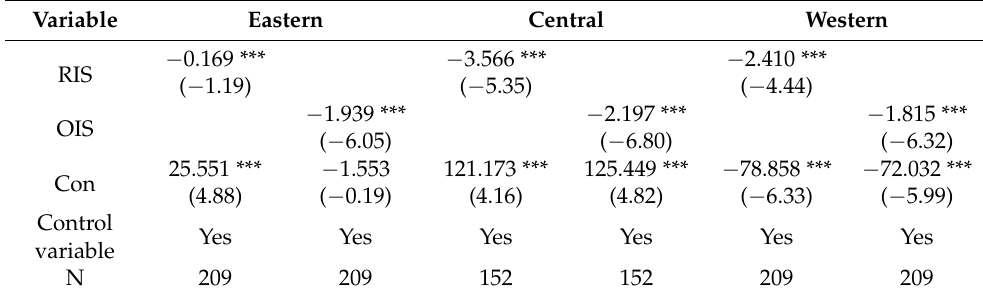
Table 5. Regression results by